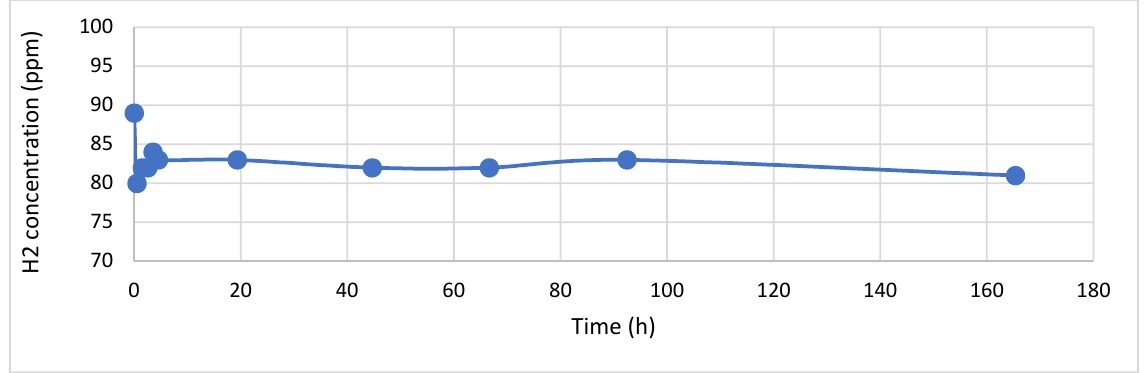
Figure 3. Evaluation of GA5000 sensor stability as a function of time. The readings were obtained by exposing the sensor to a known hydrogen gas concentration.